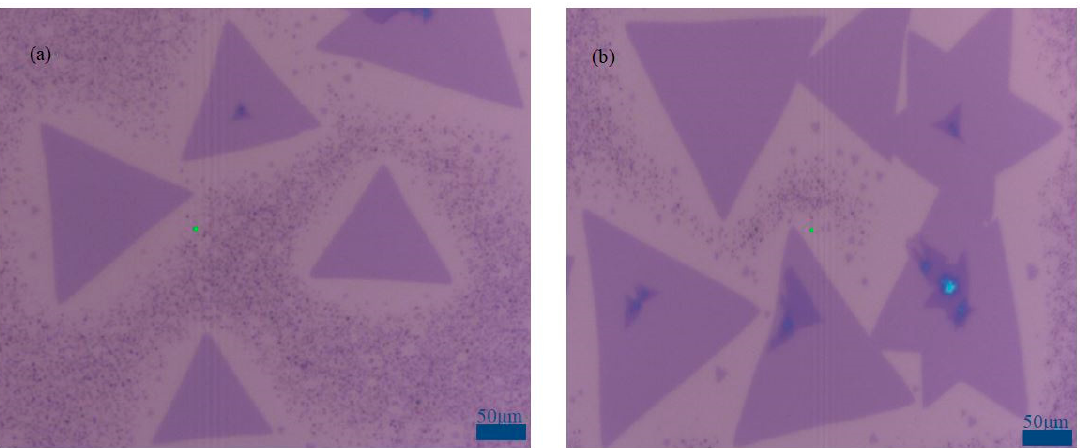
Figure 4. Growth of different regions MoS 2 on SiO 2 /Si substrate under optimal treatment condition ( a ) first region; ( b ) second region Scale bar: 50 μ m.